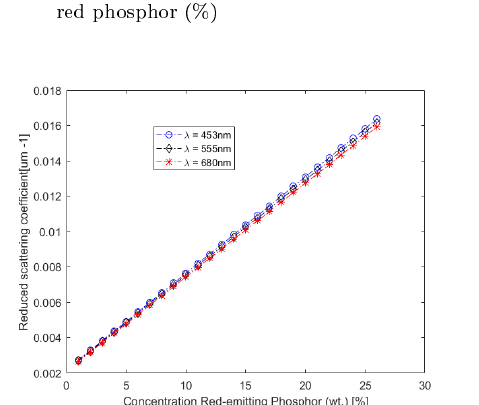
Fig. 4: Reduced scattering